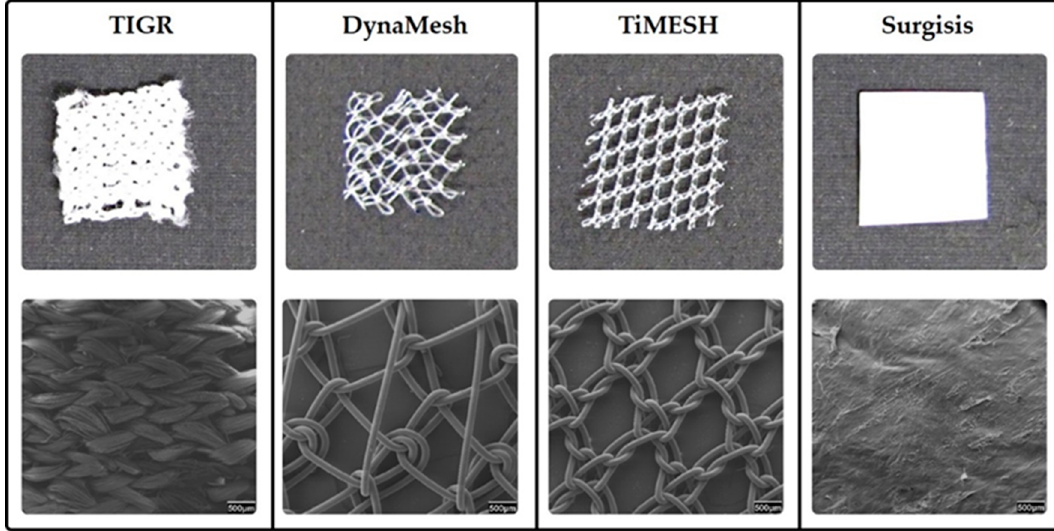
Figure 4. Top images: Macroscopic appearance of a matrix long-term absorbable mesh (TIGR®), hybrid meshes (DynaMesh® and TiMESH®), and a biological mesh (Surgisis®). Bottom images: Scanning electron microscopy images showing a magnified view of the structure of the meshes (20x magnification).